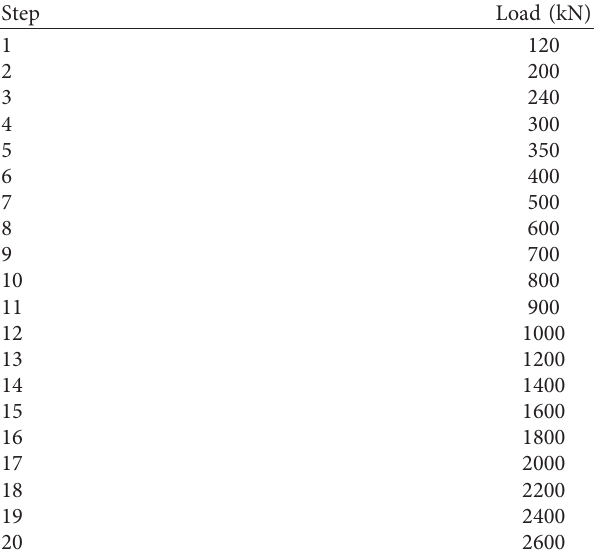
Table 1: Loading steps in the